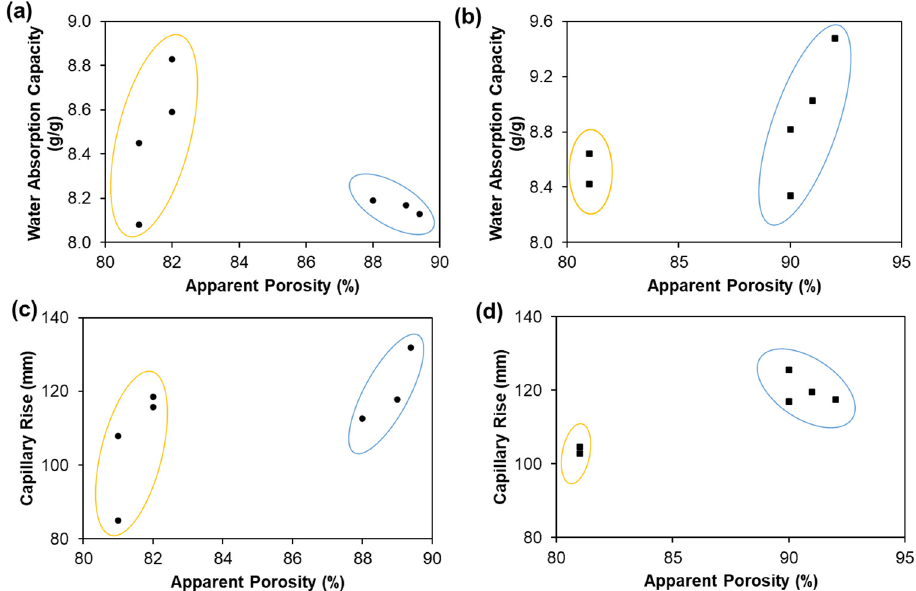
Figure 2. Water absorption capacity as function of apparent porosity of hardwood ( a ) and softwood ( b ) fiber pulps, as well as capillary rise as function of apparent porosity of hardwood ( c ) and softwood ( d ) fiber pulps.